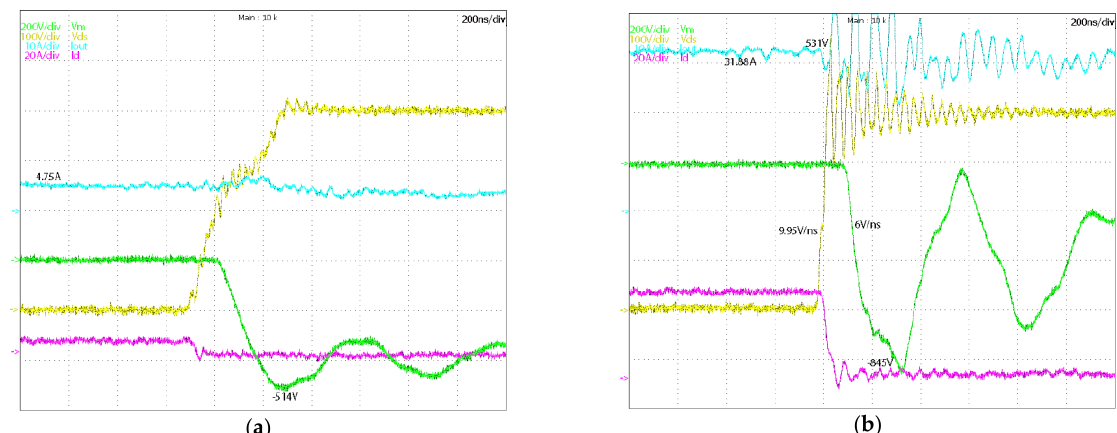
Figure 9. Turn-off of S A , t located in the three-phase 2L inverter with R G = 4.7 Ω, dead-time DT = 1 µ s, switching frequency f sw = 10 kHz and l C = 15 m: ( a ) phase current of 4.75 A, ( b ) phase current of 31.88 A. Line-to-line voltage V m at the motor side (green track), drain-source voltage V DS of the S A , t (yellow track), drain current of S A , t (magenta track) and phase current I A (ciano track).